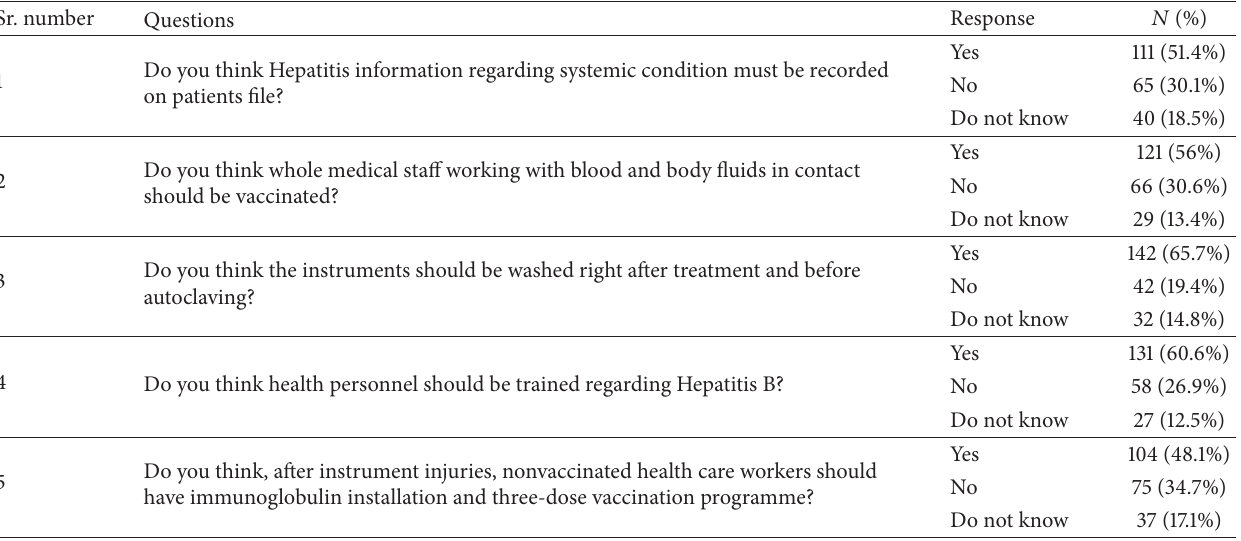
Table 2: Opinions of students regarding Hepatitis